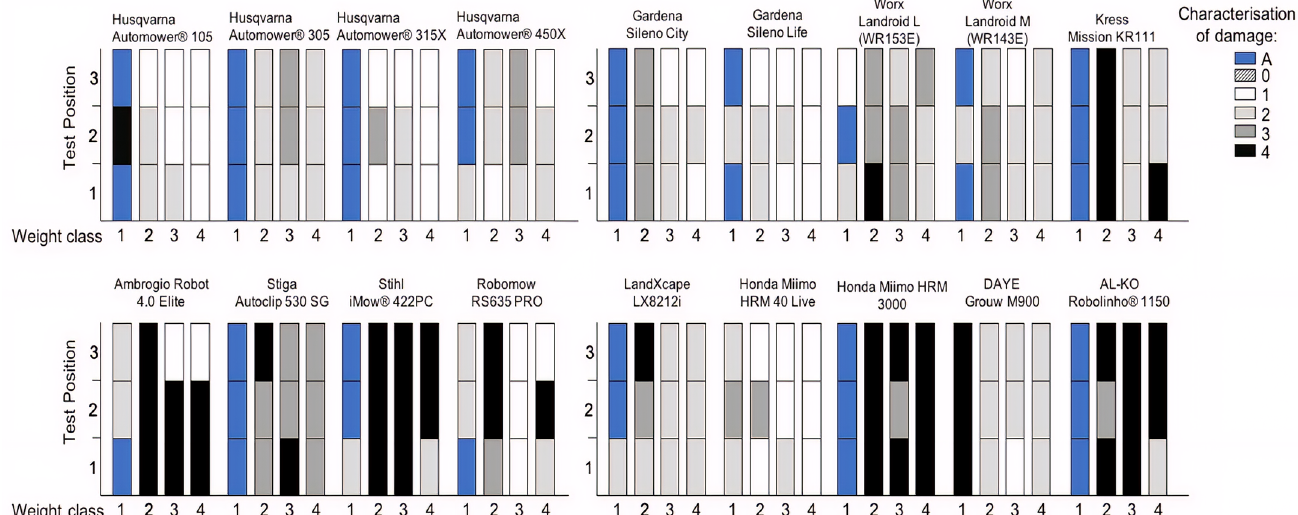
Figure 3. The test results for each of the 18 robotic lawn mowers tested. Every result for each of the four weight classes in each of the three positions have been described based on a categorisation of damage ranging from 0 to 4, with damage category 4 being the most severe. Damage category A represents the events where the machine does not detect the juvenile hedgehog (<200 g, weight class 1) and continues to drive across the juvenile hedgehog, but as the body of the small hedgehog is situated below the blades of the robotic lawn mower, the juvenile hedgehog is left with no visible injuries or bruises.